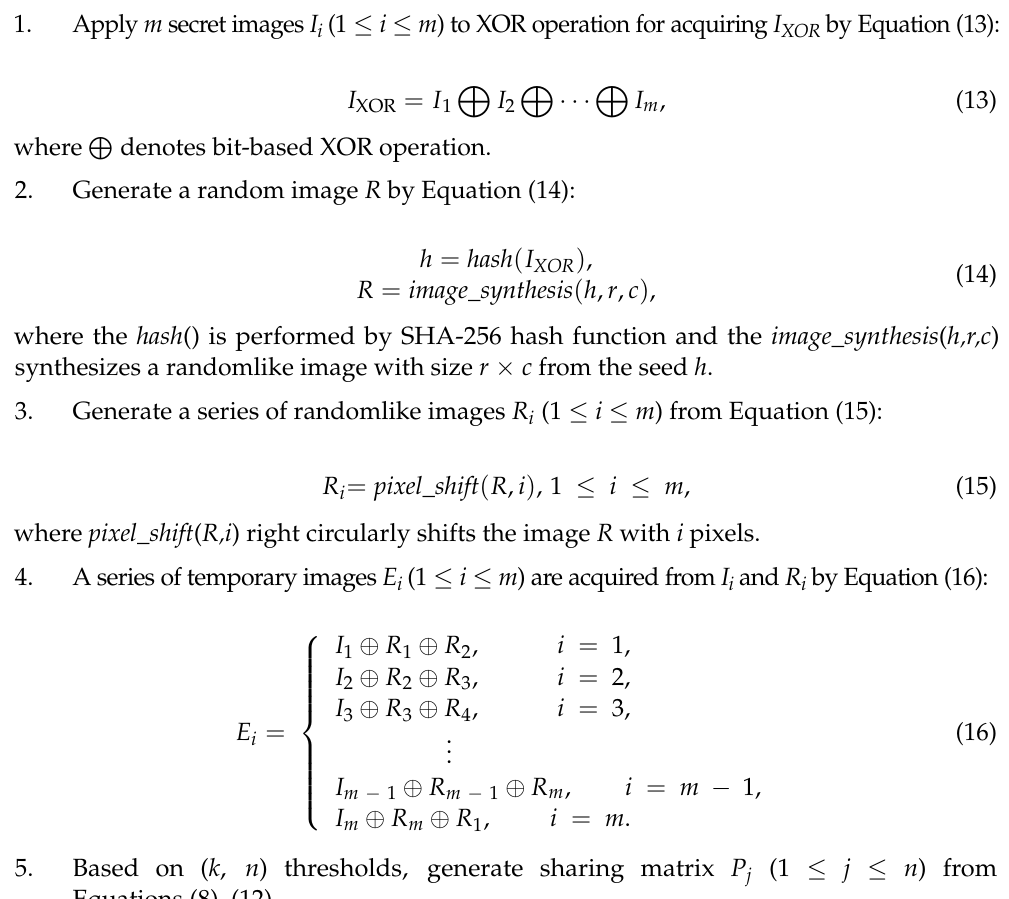
Figure 4. Processes of the first proposed source-random-mixed ( SRM ) sharing algorithm.